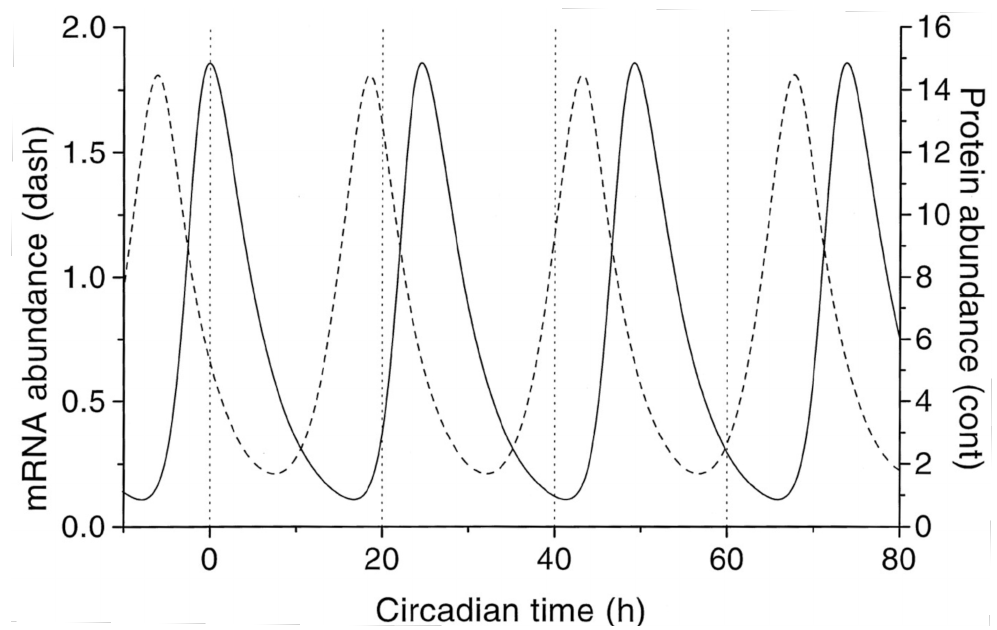
Figure 5. The mRNA and protein abundance oscillation across a certain period of circadian